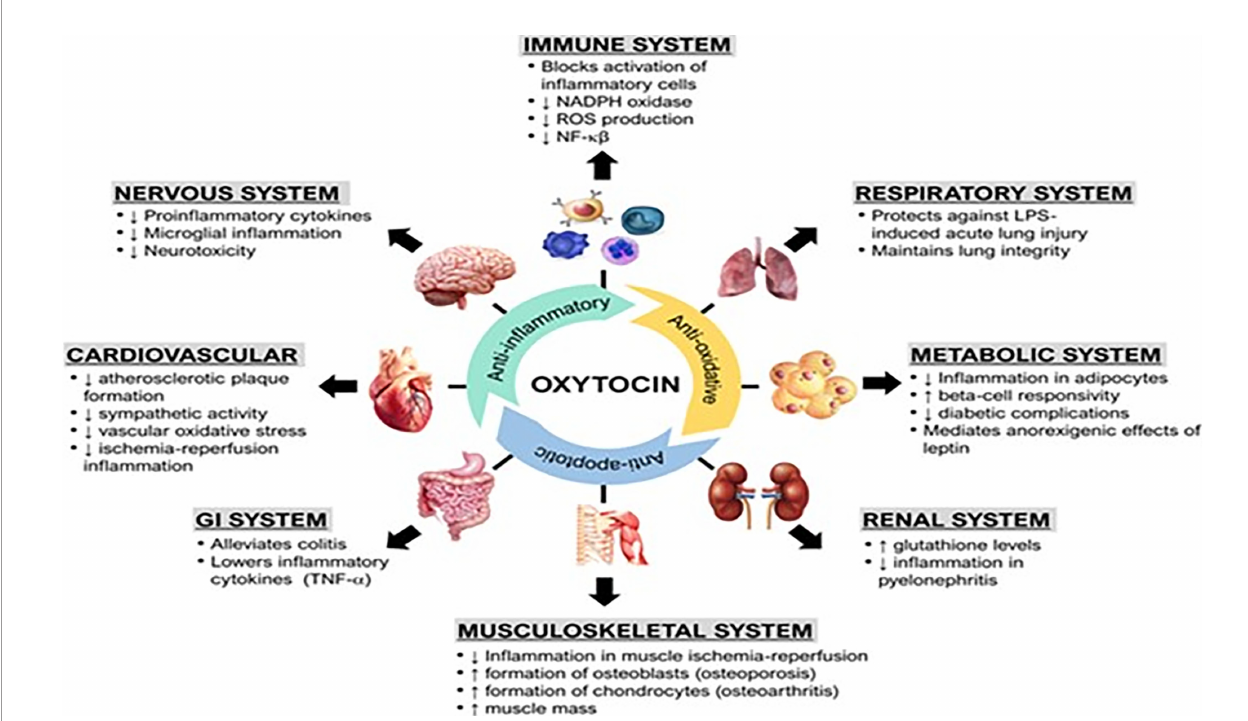
FIGURE 1 | (Original by authors of the manuscript): The anti-in fl ammatory effects of oxytocin on various body organ systems. NADPH, nicotinamide adenine dinucleotide phosphate; NF-kB, nuclear factor kappa-light-chain-enhancer of activated B cells; ROS, reactive oxygen species; TNF- a , tumor necrosis factor-alpha. Up arrow ( ↑ ) symbol indicates increase, whereas down ( ↓ ) arrow symbol indicates decrease in the effect